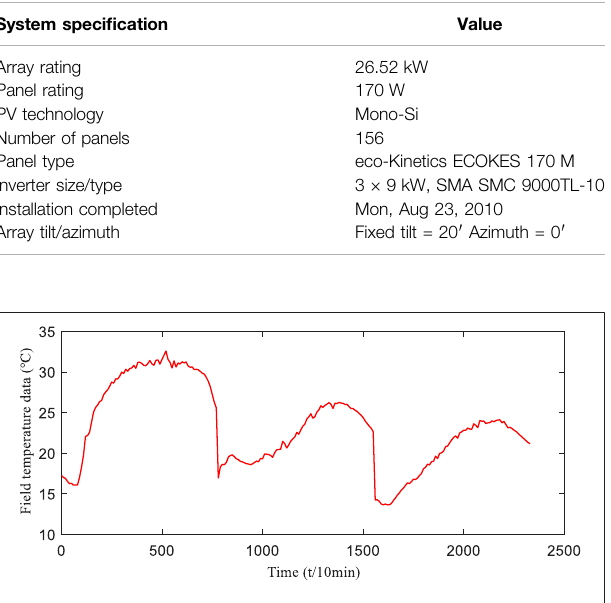
FIGURE 3 | NWP temperature data in forecasting